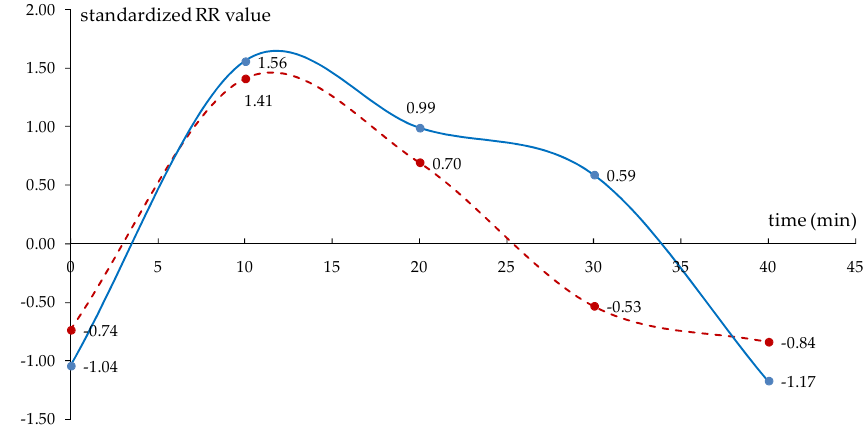
Figure A3. Temporarily disaggregated series of the RR–MGS Huichapan (red line) and RR–satellite image (blue line) during the Hurricane Manuel (16 Sep 2013), final step.